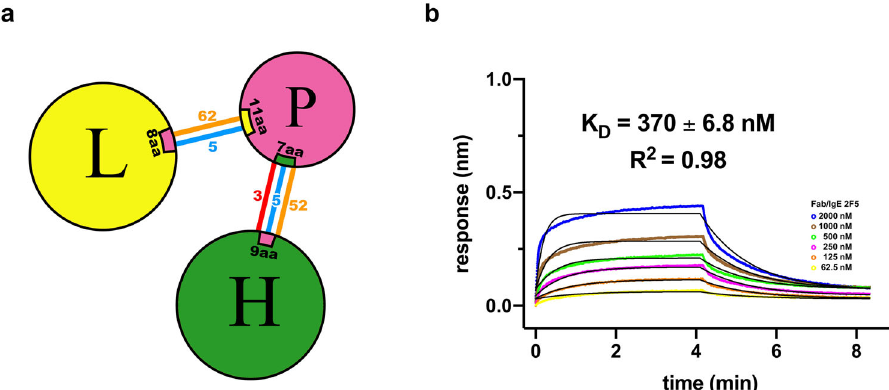
Fig. 6 Paratope-epitope interactions and af fi nity of the Fab/IgE 2F5. a Interaction network summary. Heavy chain (H), light chain (L), and pro fi lin (P). Salt bridges are represented as red lines, hydrogen bonds as blue lines, and nonbonded contacts (electrostatics and van der Waals interactions) with orange lines. b BLI fi tting considering nonspeci fi c binding (NSB) using the Association-Dissociation model implemented in GraphPad Prism 8 and a 1:1 model. Six different concentrations were tested and are shown in different